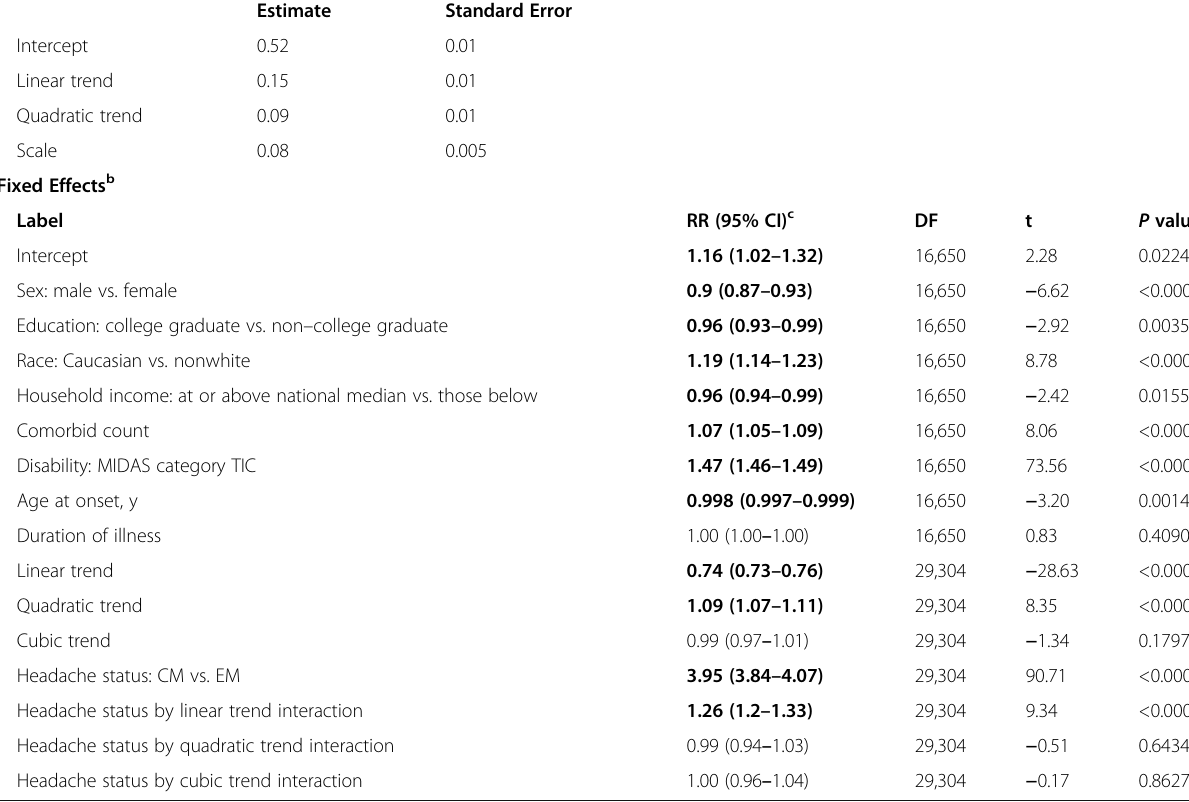
Table 3 Final adjusted and trimmed model for headache days per month a Random-Effect Variance Parameter